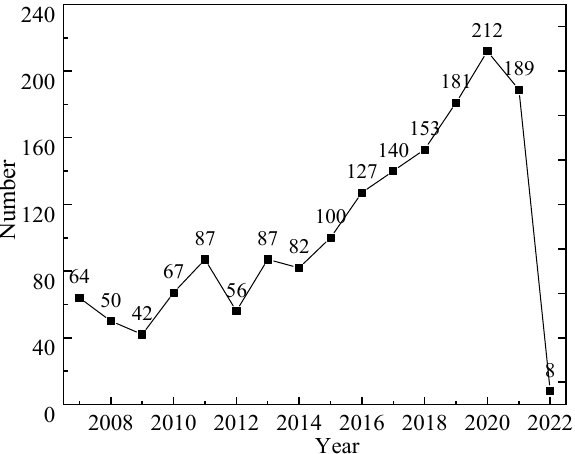
Figure 1. The number of articles published from 2007 to